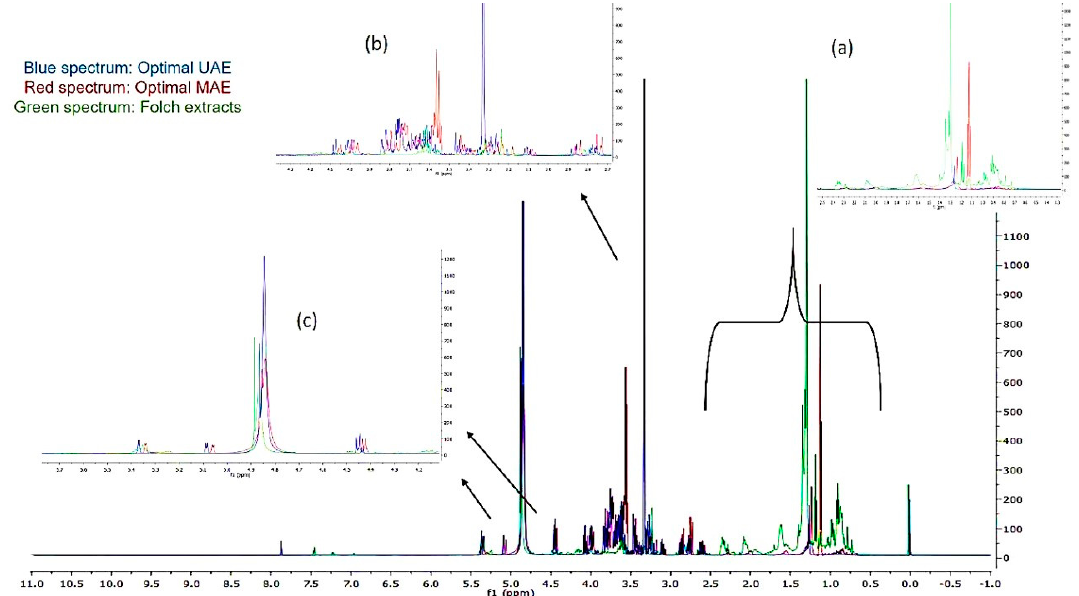
Figure 5. Regions of ( a ) amino acids, ( b ) fatty acids and myo-inositol, and ( c ) mono- and di-saccharides in superimposed 1 H-NMR spectra of optimal UAE, optimal MAE, and Folch extracts.